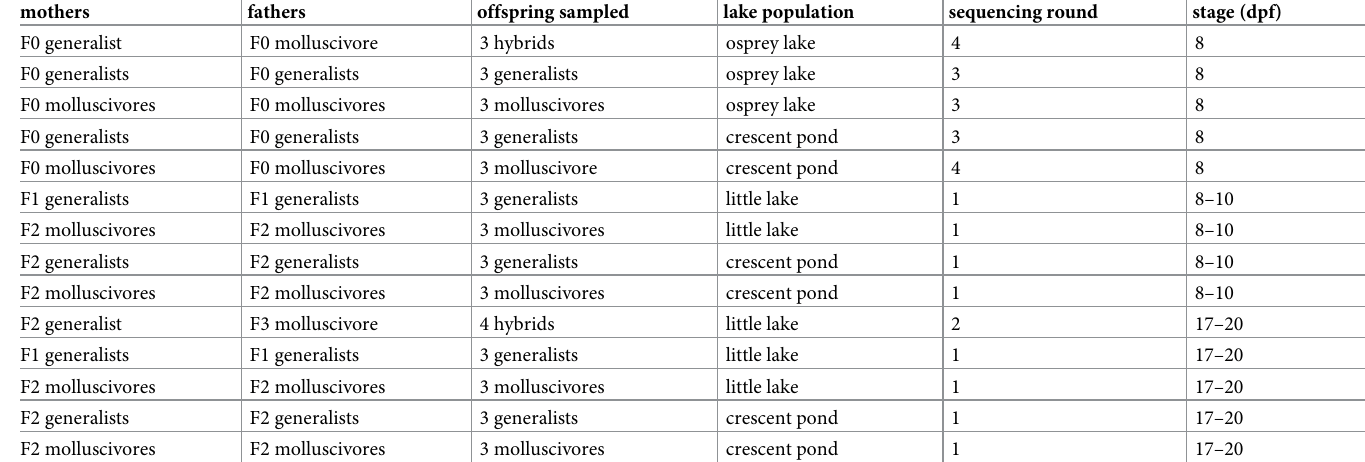
Table 1. Sampling design for mRNA sequencing. Parental fishes crossed to produce larvae for sequencing were either wild-caught (F0) or lab-raised over n generations (indicated by F n ). Individuals were sampled eight days post fertilization (dpf), 8–10 dpf, or 17–20